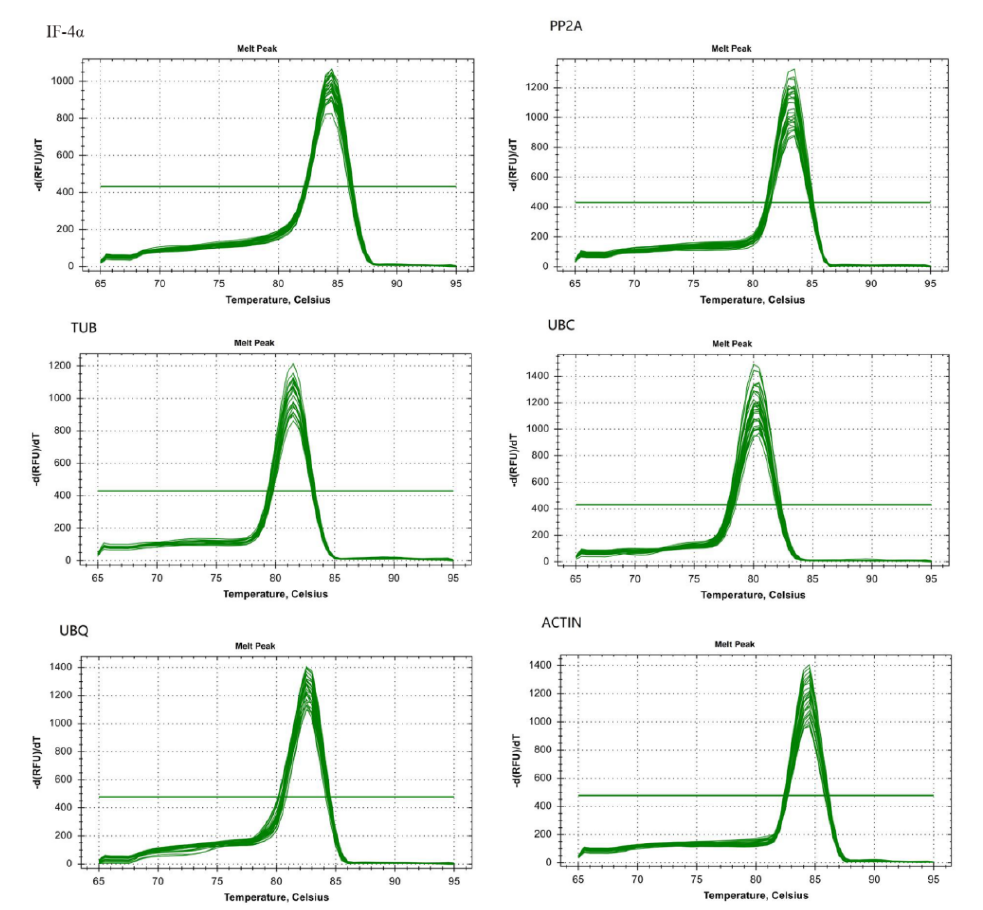
Figure 2. Melting curve analysis of eight candidate reference genes of stem mustard.